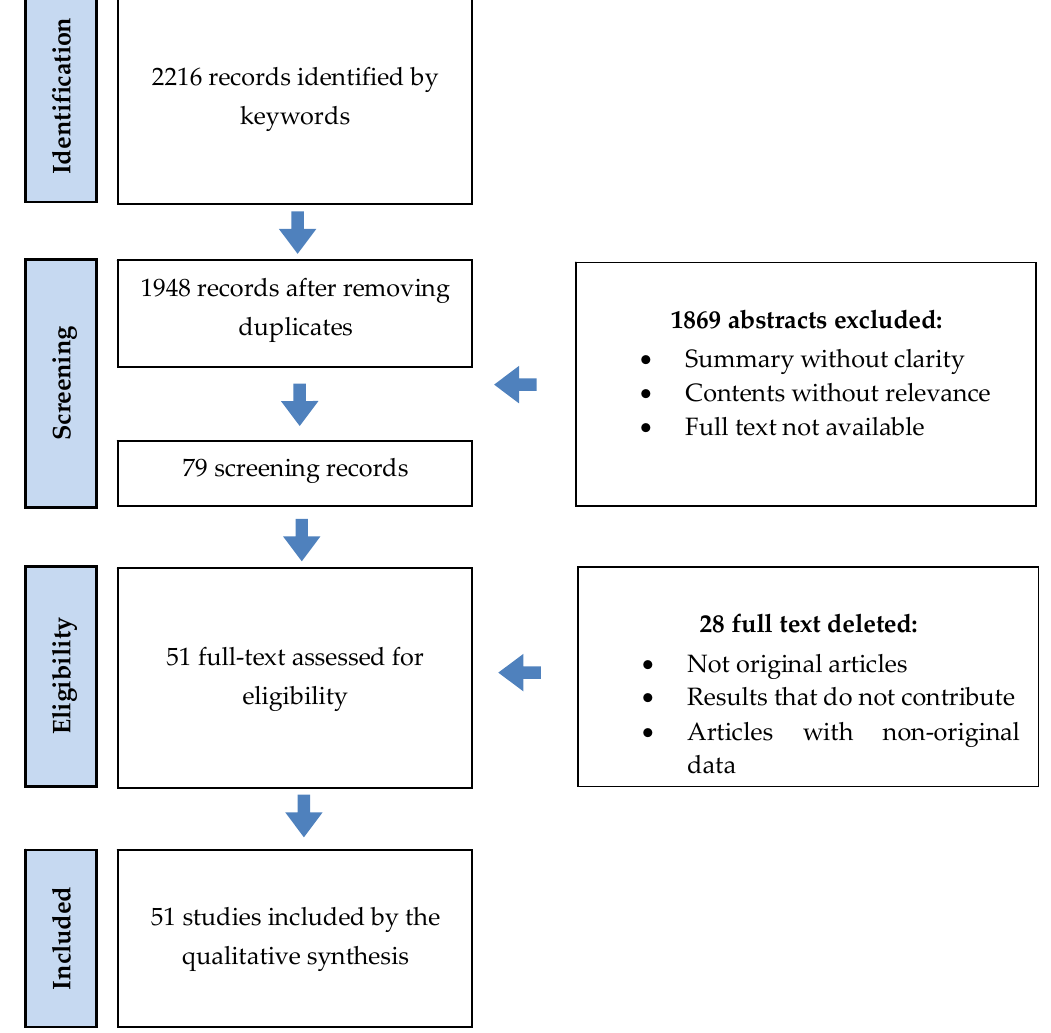
Figure 1. Synthesis of bibliographic research from the PRISMA flowchart.